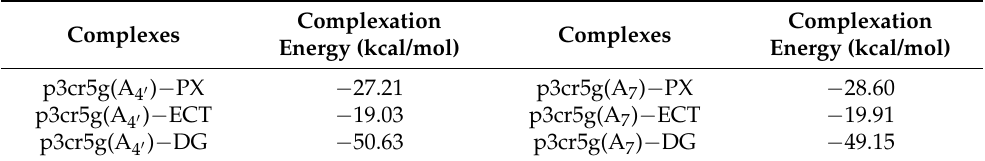
Table 4. Calculated quantum chemical parameters of p3cr5g compound − binary complex. Complexation Complexes Energy (kcal/mol)